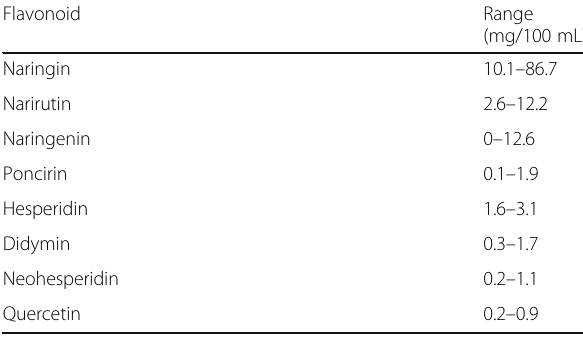
Table 1 Flavonoid content in grape fruit juice